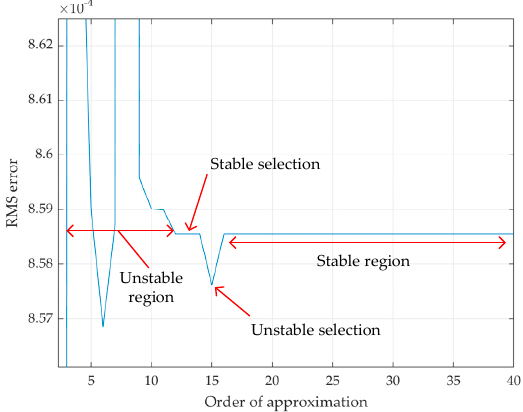
Figure 4. Identification of stable model order.